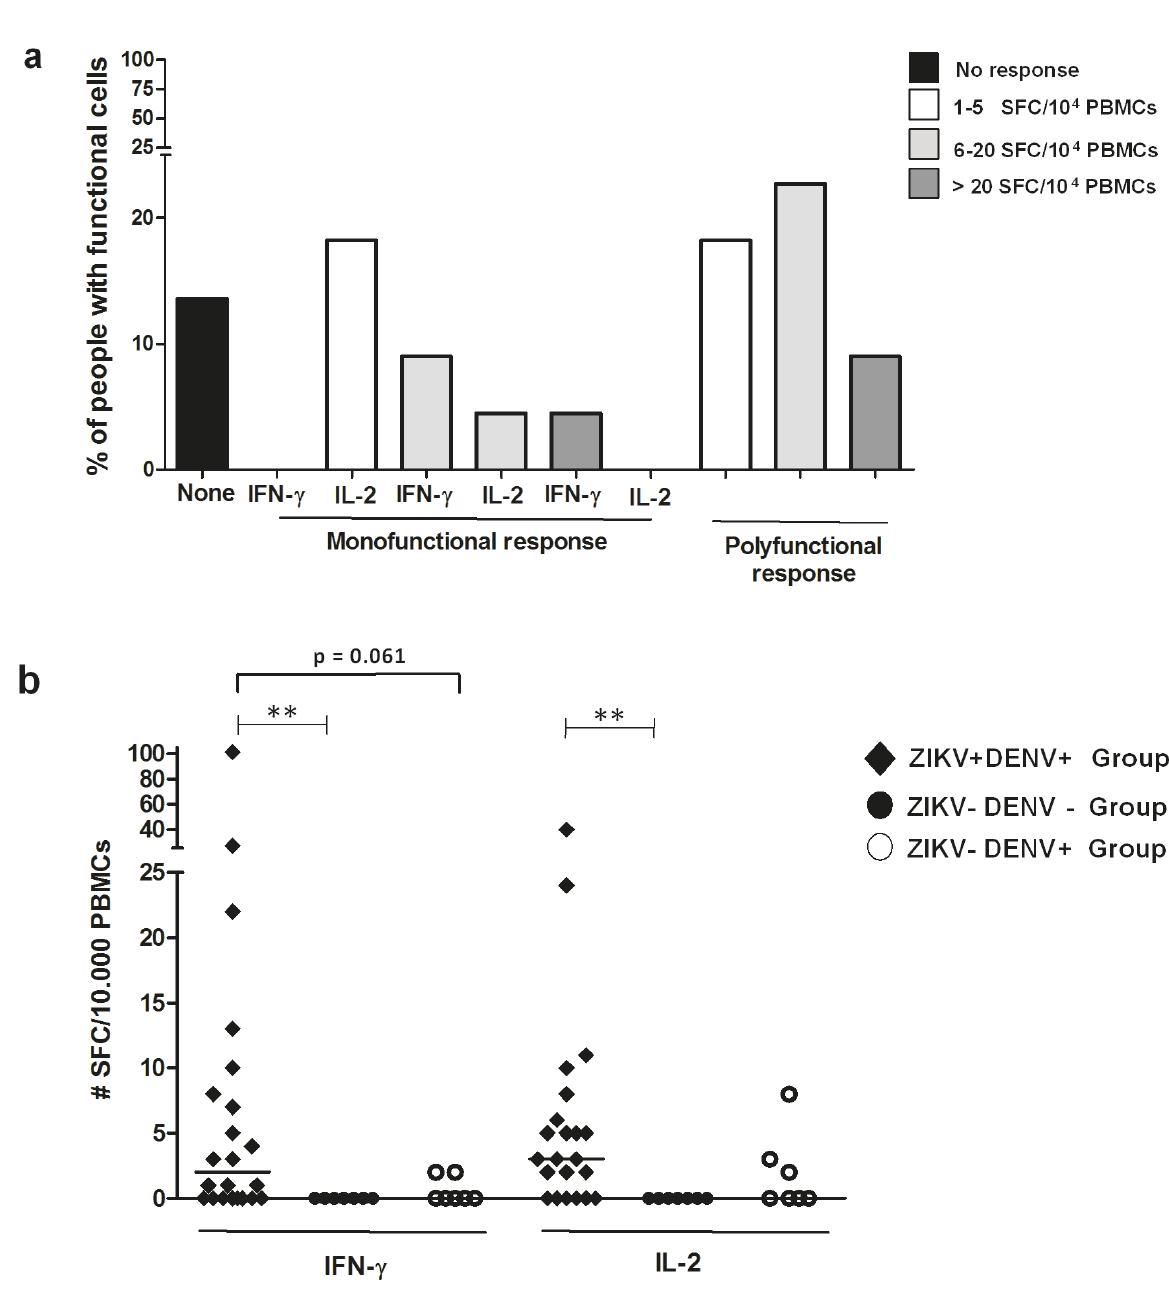
Figure 1. Cell functionality against ZIKV. ( a ) Bars represent the relative frequency of population with monofunctional (single cytokine) or multifunctional (two cytokines) response following ex vivo stimulation with Zika virus. At multifunctional level for the lower scale (low intensity) it was taken into account that for each individual both cytokines, a range of 1-5 functional cells/10 4 PBMCs were identified; the number of cells producing one of the two cytokines was in the range of 6-20 functional cells /10 4 PBMCs for the intermediate scale, and for the higher scale (high intensity), the number of cells producing one of the two cytokines was greater than 20 functional cells/10 4 PBMCs. ( b ) the dots represent the number of Spot Forming Cells for each individual evaluated within the ZIKV+DENV+, ZIKV-DENV- and ZIKV-DENV+ groups after the viral stimulus. The horizontal line corresponds to the median value. *p> 0.05 and ** p> 0.01 using Mann-Whitney U